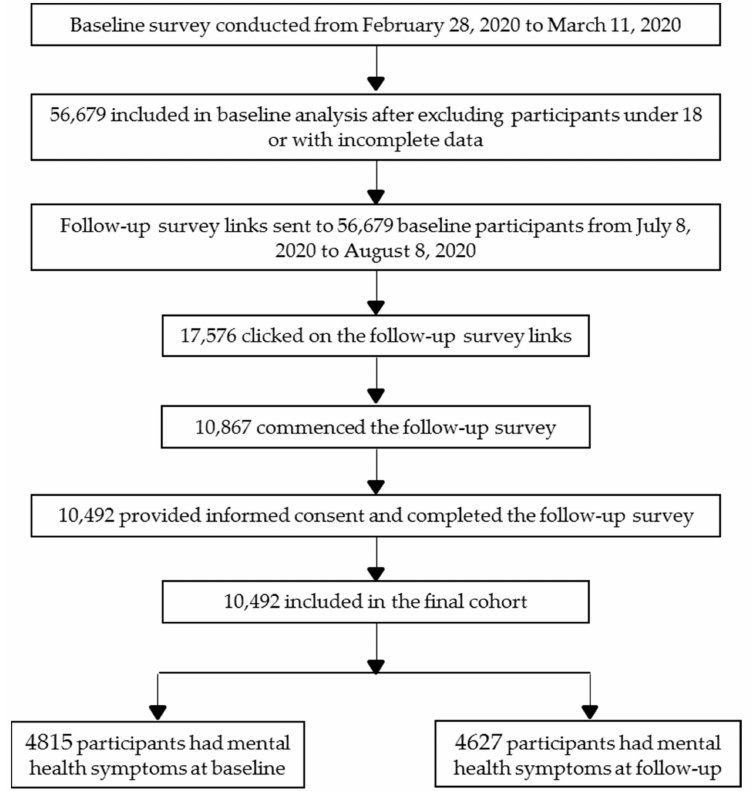
Figure 1. Flow chart of participants